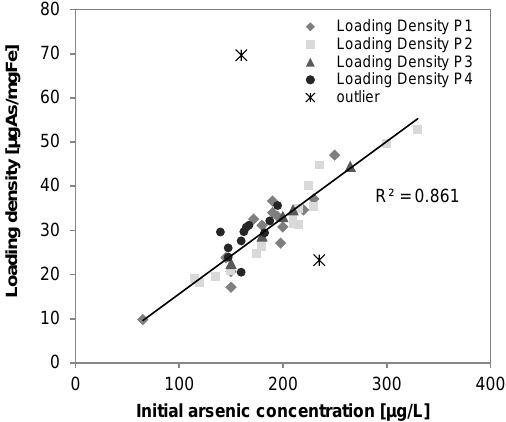
Figure 14. Correlation of arsenic loading densities on iron precipitates and initial arsenic concentration in groundwater (R 2 = 0.86, n = 49).